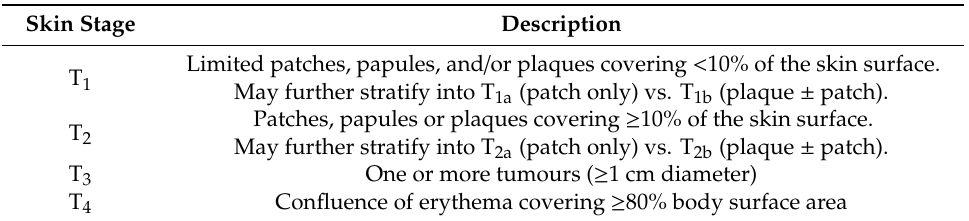
Table 4. ISCL / EORTC revision to the classification of skin involvement in patients with mycosis fungoides and Sezary syndrome